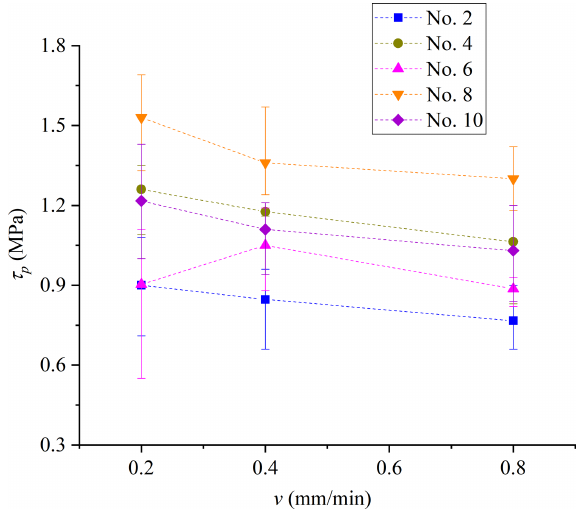
Figure 11. Effect of shear rate on the peak shear strength. Experi- mental conditions: T =− 5 ◦ C, d = 2mm and σ n =